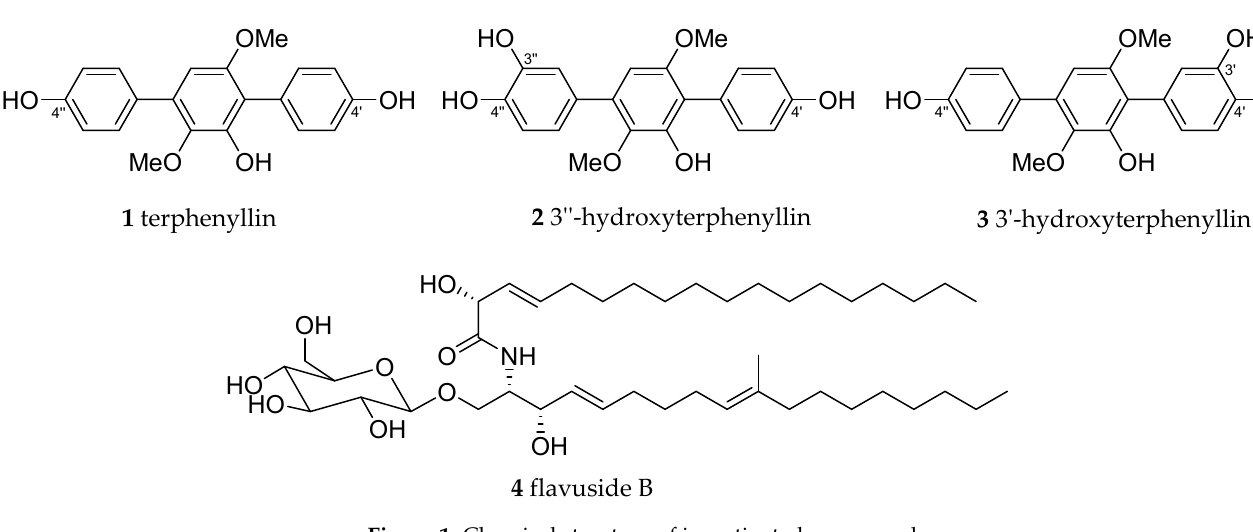
Figure 1. Chemical structure of investigated compounds.